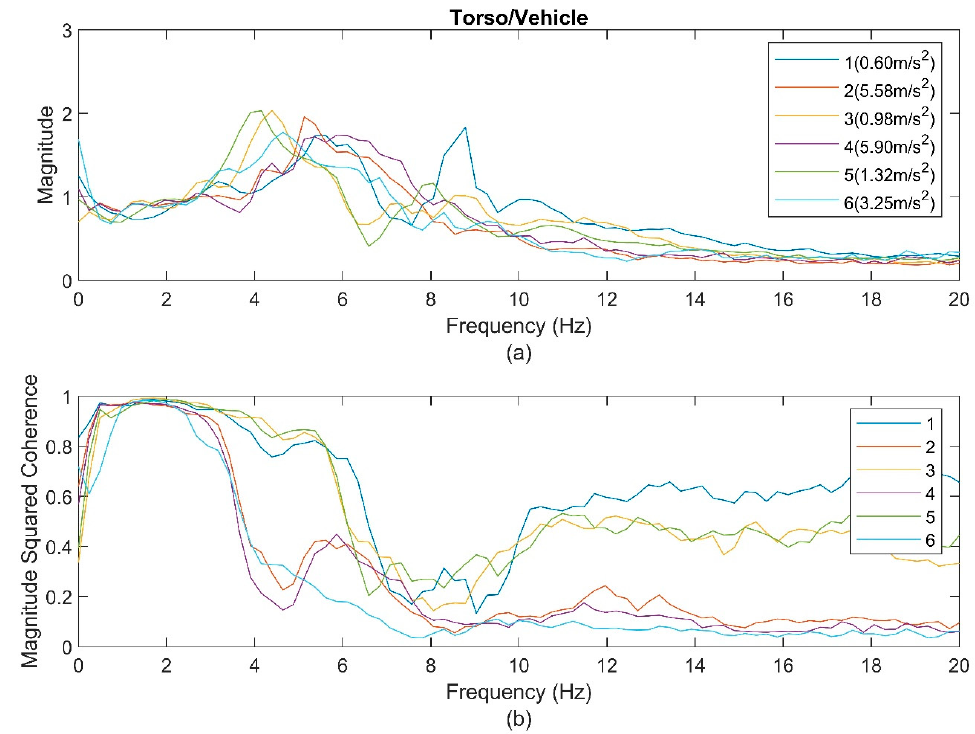
Figure 3. ( a )The transmissibility of the vertical acceleration of the torso relative to the vehicle floor for Sections 1–6; the corresponding RMS values of the vertical acceleration for each section are provided in parentheses beside the legends, and ( b ) the corresponding squared coherence graphs.